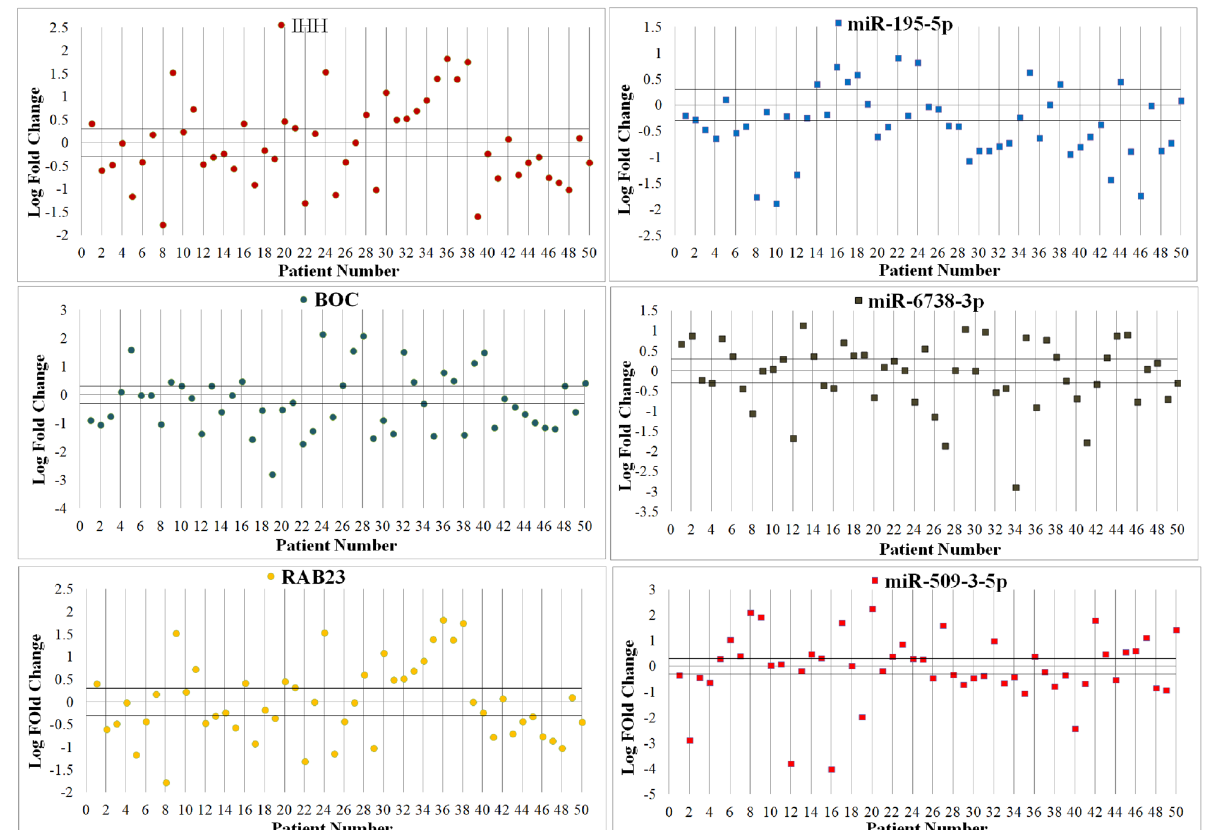
Figure 2. Scatter plot expression of Shh signaling pathway genes and their regulatory miRNAs in tumoral and adjacent non-tumoral tissues. Gene expression variations were considered in 50 gastric adenocarcinoma patients. Each plot represents a person’s gene expression change in tumor tissue in comparison with adjacent normal tissue. Horizontal lines represent cut-off values corresponding to log two-fold changes in expression. The upper and lower parts of the horizontal lines indicate upregulation, and downregulation in the tumoral tissues in comparison with non-tumoral tissues,